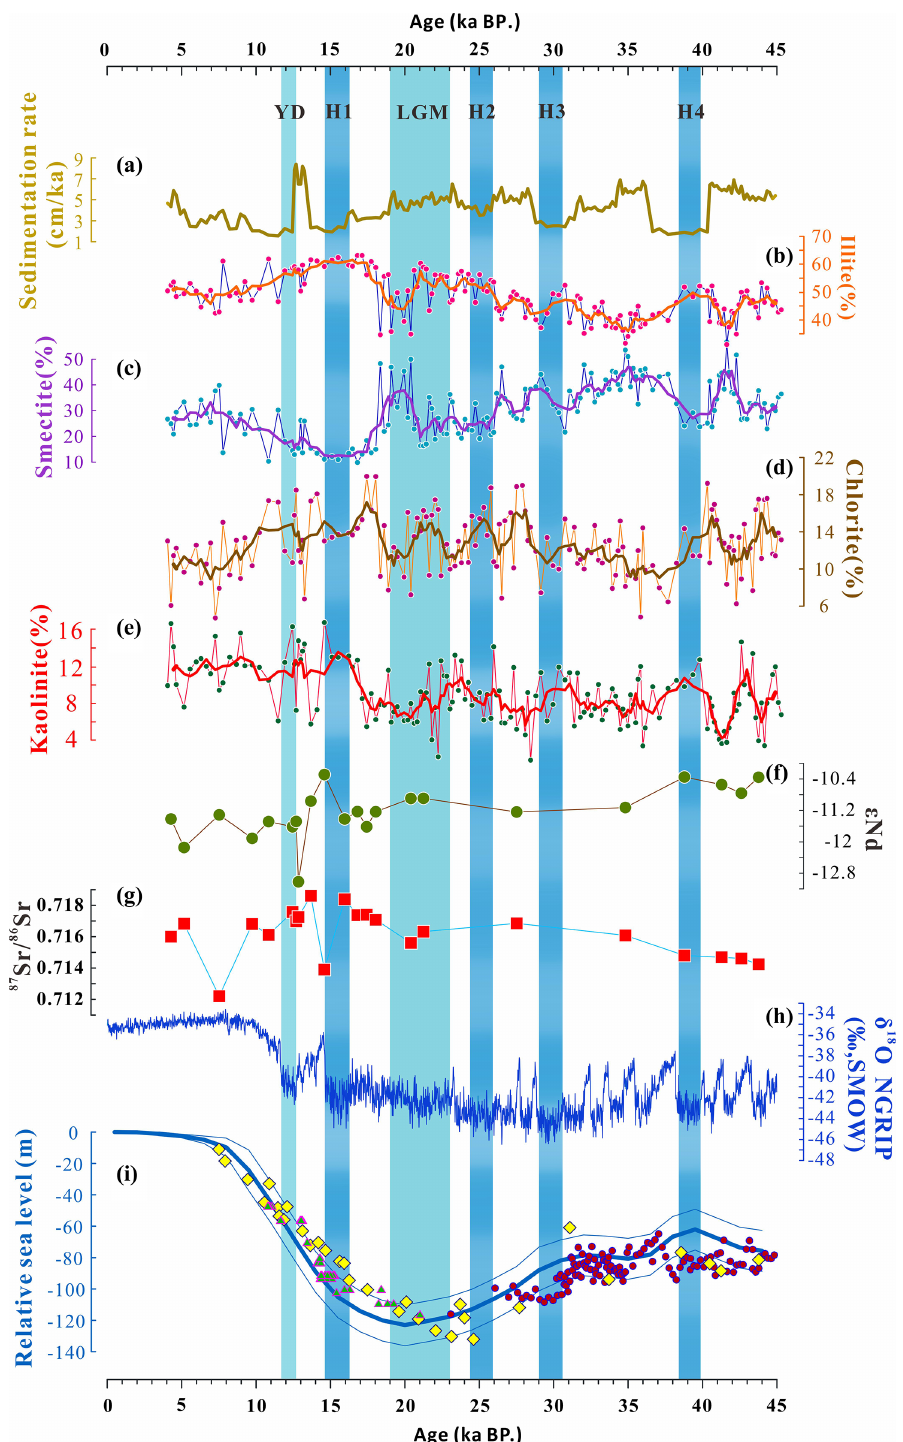
Figure 3. Comparison of clay mineral and Sr–Nd isotope data in the northeastern Indian Ocean with paleoclimate records. (a) Sedimentation rate in core 17I106. (b, c, d, e) Illite, smectite, chlorite, and kaolinite percentages in core 17I106 (thick line represents a three-point running average). (f, g) 87 Sr/ 86 Sr and ε Nd values of core 17I106 in the northeastern Indian Ocean. (h) δ 18 O data from a Greenland ice core – NGRIP (Svensson et al., 2008). (i) Global sea level as a proxy for ice volume, reconstructed from benthic δ 18 O (thick cyan line; the thin cyan line represents the 95% confidence interval; Thompson and Goldstein, 2006), globally distributed corals (yellow dots, Waelbroecka et al., 2002), and sea level data (triangles and red dots) collected by Grant et al. (2014) and Hanebuth et al. (2000). Blue and cyan bars represent cold-climate periods of Heinrich events (H1–H4) together with Younger Dryas (YD) and the Last Glacial Maximum (LGM), respectively. Clim. Past, 18, 1369–1384, 2022